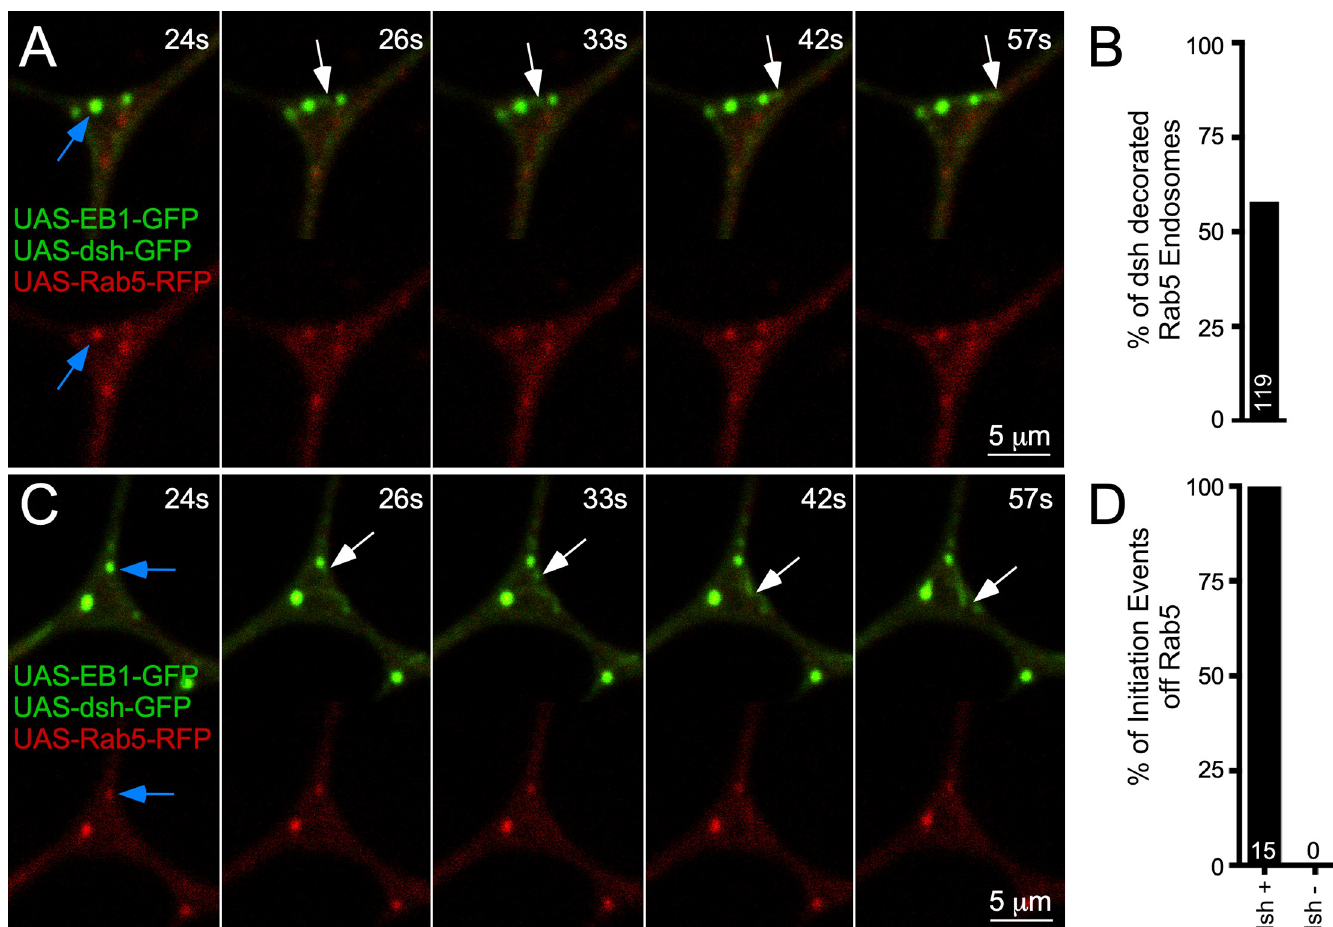
Fig 7. Microtubules initiate from dsh-decorated early endosomes. (A and C) Frames from two representative videos of a class I neuron expressing UAS-EB1-GFP, UAS-dsh-GFP, and UAS-Rab5-RFP. Top panels are the merged image, and bottom is the UAS-Rab5-RFP. A blue arrow is used to show the endosome from which an EB1 comet will initiate in subsequent frames, indicated with white arrows to track movement. The time stamp at the top-right corner correlates to the time point in the corresponding S13 and S14 Movies. (B) Quantification of the percentage of Rab5 endosomes that are labeled with UAS-dsh-GFP. Sample size is shown in the bar and indicates total number of Rab5-RFP puncta that were counted in branch points during 25 300-second videos. (D) Quantification of EB1 comet events that initiate from dsh-positive or dsh-negative Rab5 endosomes during the same 300-second videos. Sample size, which represents total comet number, is shown in the bar. Refer to S1 Table for all genotypes and S1 Data for data used to generate graphs in (B) and (D). dsh, dishevelled; EB1, end-binding protein 1; GFP, green fluorescent protein; RFP, red fluorescent protein; UAS, upstream activating sequence.